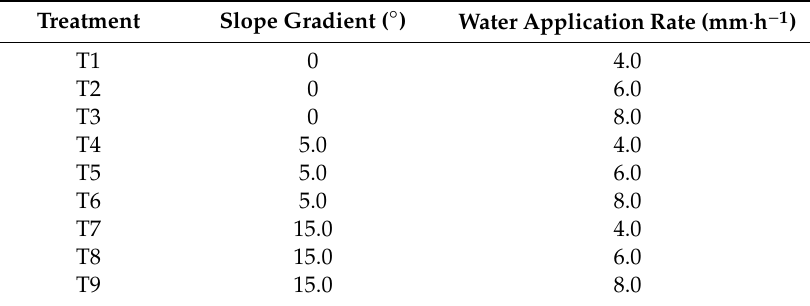
Table 3. Sprinkler irrigation